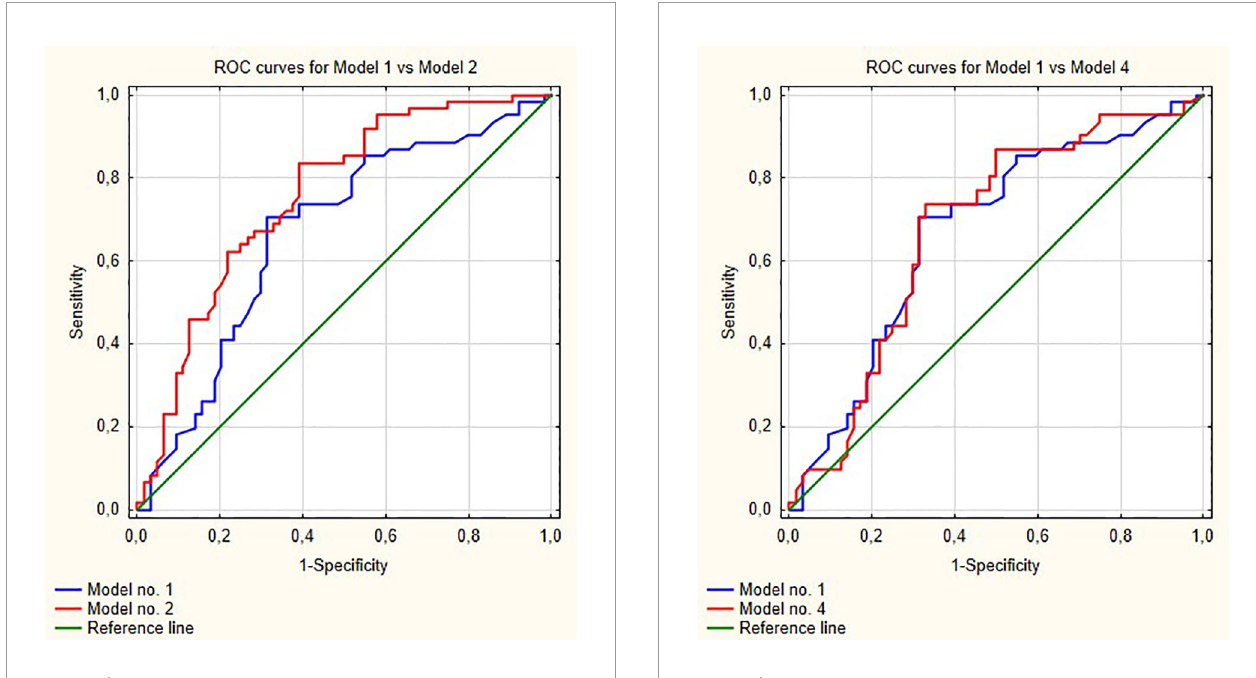
FIGURE 1 | Comparisons of ROC curves for models 1 and 2. AUC for model 1 — 0.670; model 2 — 0.756, p = 0.001.